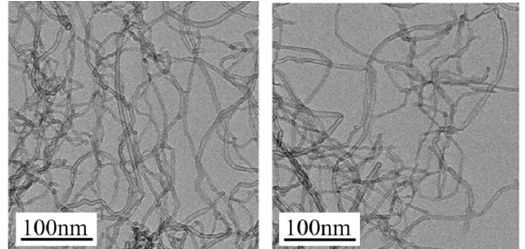
Figure 1. The diameter and micromorphology of the original multiwalled carbon nanotubes were characterized by transmission electron microscopy. (Note: the data used in this figure are provided by the Chengdu Organic Chemicals Co., Ltd., Chinese Academy of Sciences, Chengdu, China.).